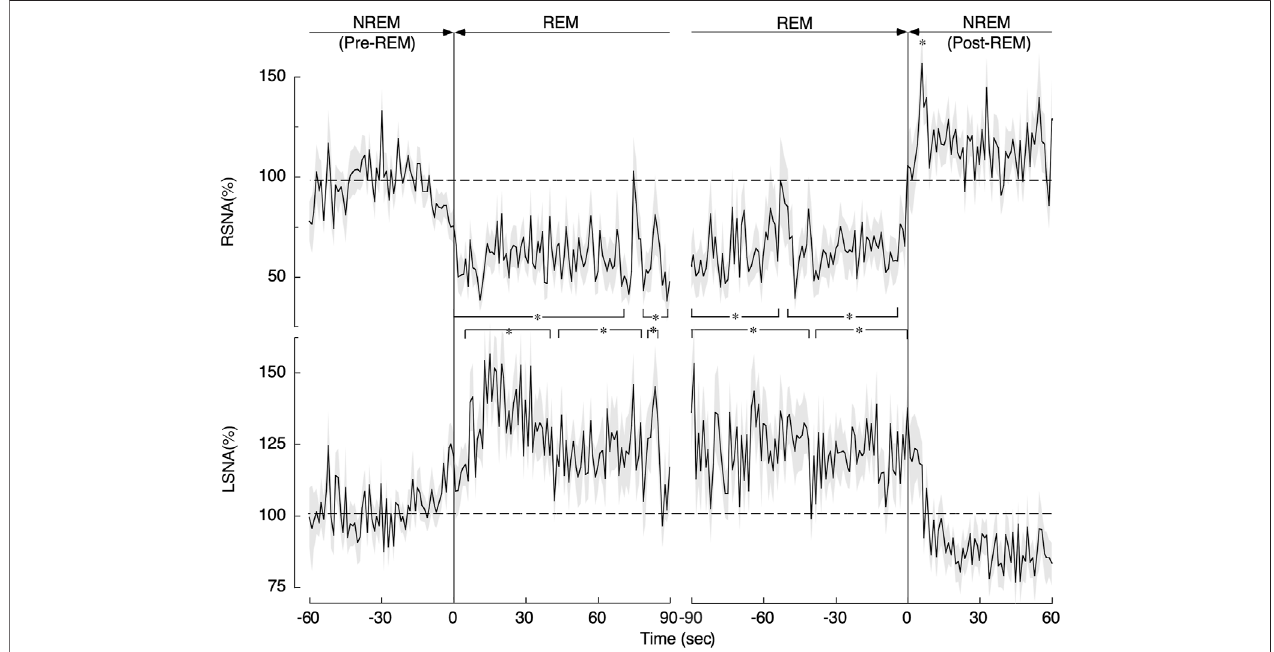
FIGURE 2 | Changes in renal sympathetic nerve activity (RSNA) and lumbar sympathetic nerve activity (LSNA) during the transition from non-rapid eye movement (NREM) sleep (pre-REM) to REM sleep and from the REM sleep to NREM (post-REM) sleep periods. Continuous drawn lines represent mean values and shaded areas aboveandbelowshowthestandarderrorofmean.* p < 0.05indicatesasigni fi cantdifferencefromtheaveragelevelobtainedduringthepre-REMperiod.Theimagewas obtained with permission from the study by Yoshimoto et al.